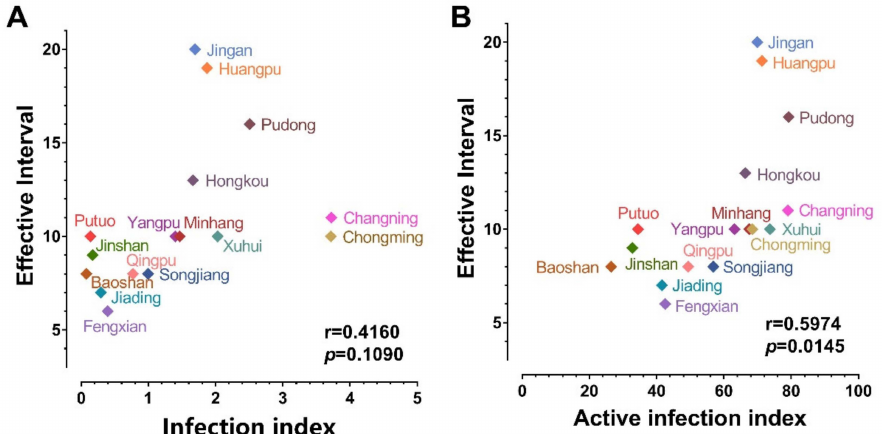
Figure 4. Correlation analysis between EI and the calculated infection index/active infection index. EI is the leading time from the lockdown starting date to the daily omicron cases peaking date in each district. The calculated infection index is an algorithm considering only the daily new infections number in each district. The calculated active infection index is an algorithm taking both the number of infected individuals and the population mobility in each district into account. Data are examined by two-tailed Pearson correlation in GraphPad Prism 9.3.1. ( A ) The correlation between EI and the calculated infection index. ( B ) The correlation between EI and the calculated active infection